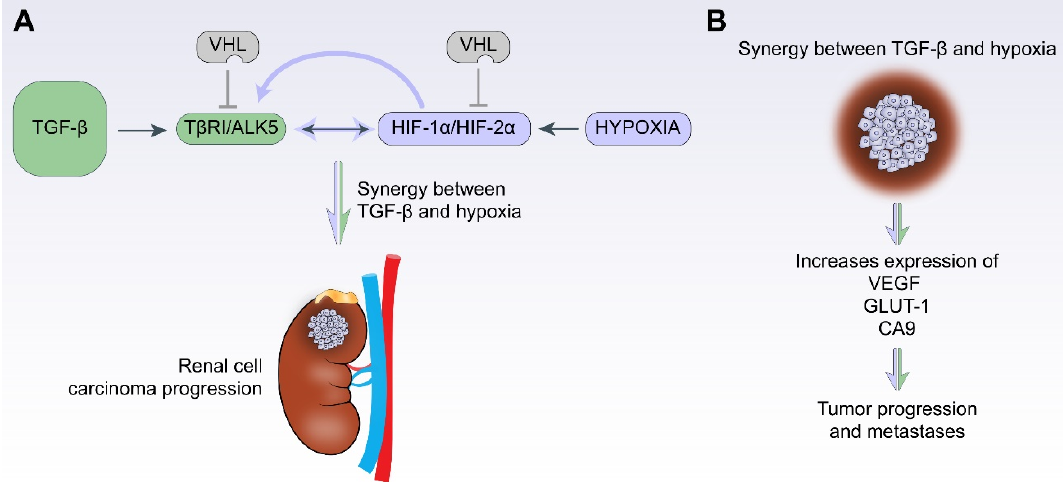
Figure 5. A graphical illustration of crosstalk between TGF- β and hypoxia in renal cell carcinoma and solid tumors. TGF- β and hypoxia pathways promote tumor progression in renal cell carcinoma ( A ) and other solid tumors ( B ) through TGF β RI (T β RI) and HIF-1 α /2 α and enhances expression of VEGF, CA9 and GLUT1 [2,67,73,123,124]. Adapted from [67].